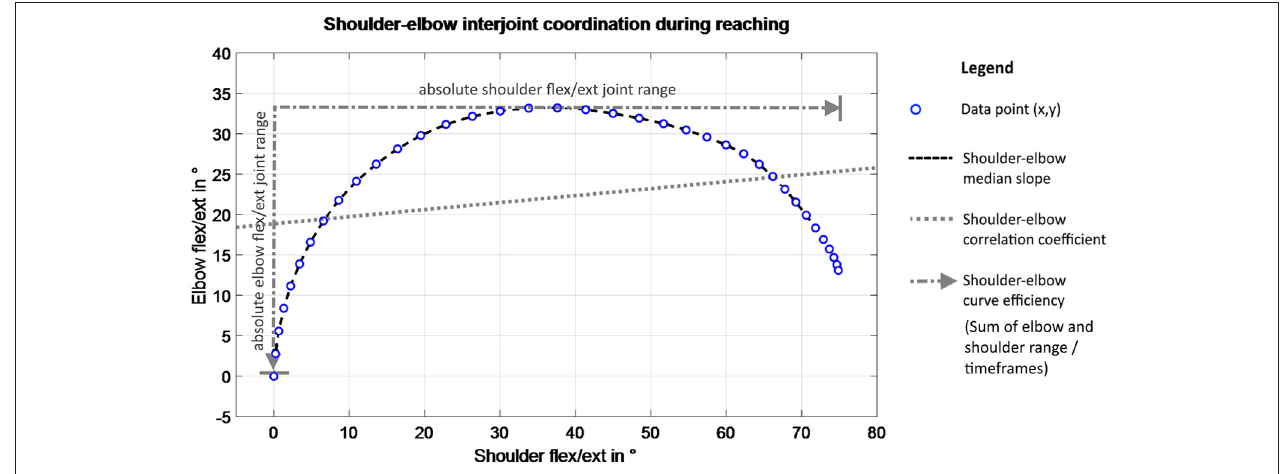
FIGURE 2 | Schematic of shoulder–elbow coordination measures.